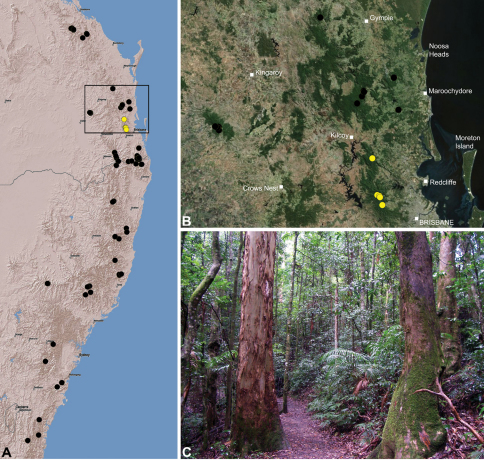
Austrarchaea raveni sp. n., distribution and habitat: A, topographic map showing the known distribution of Archaeidae in south-eastern Queensland and eastern New South Wales, with collection localities for A. raveni highlighted in yellow; B, satellite image showing detail of inset (A); C, subtropical rainforest near the type locality – Mount Glorious, D’Aguilar National Park, Queensland (May 2010). Image (C) by M. Rix.